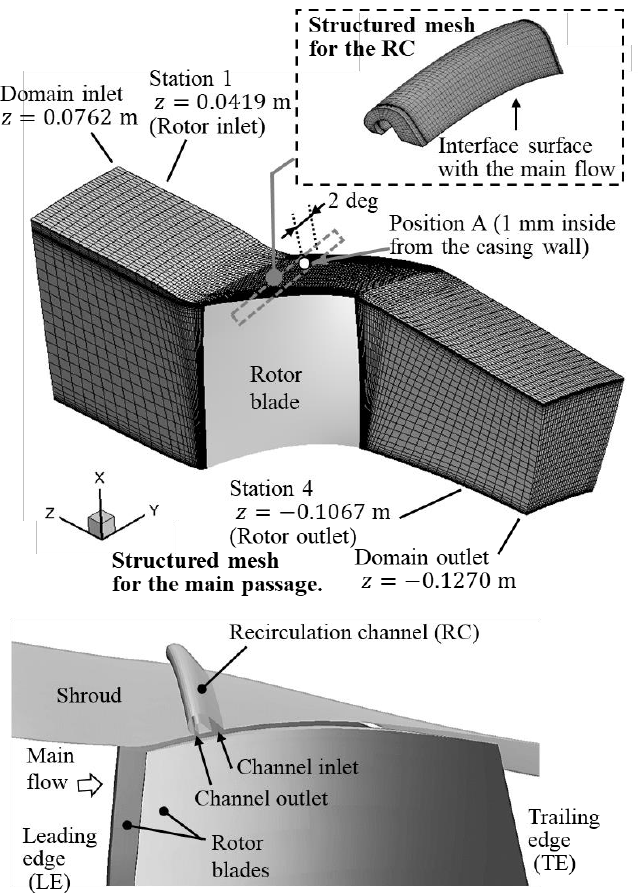
Figure 2. Three-dimensional computational domain and mesh with the recirculation channel (RC) over the rotor blades. The computational mesh is coarsened by a factor of two in the direction of each coordinate, for graphical rendering purpose.